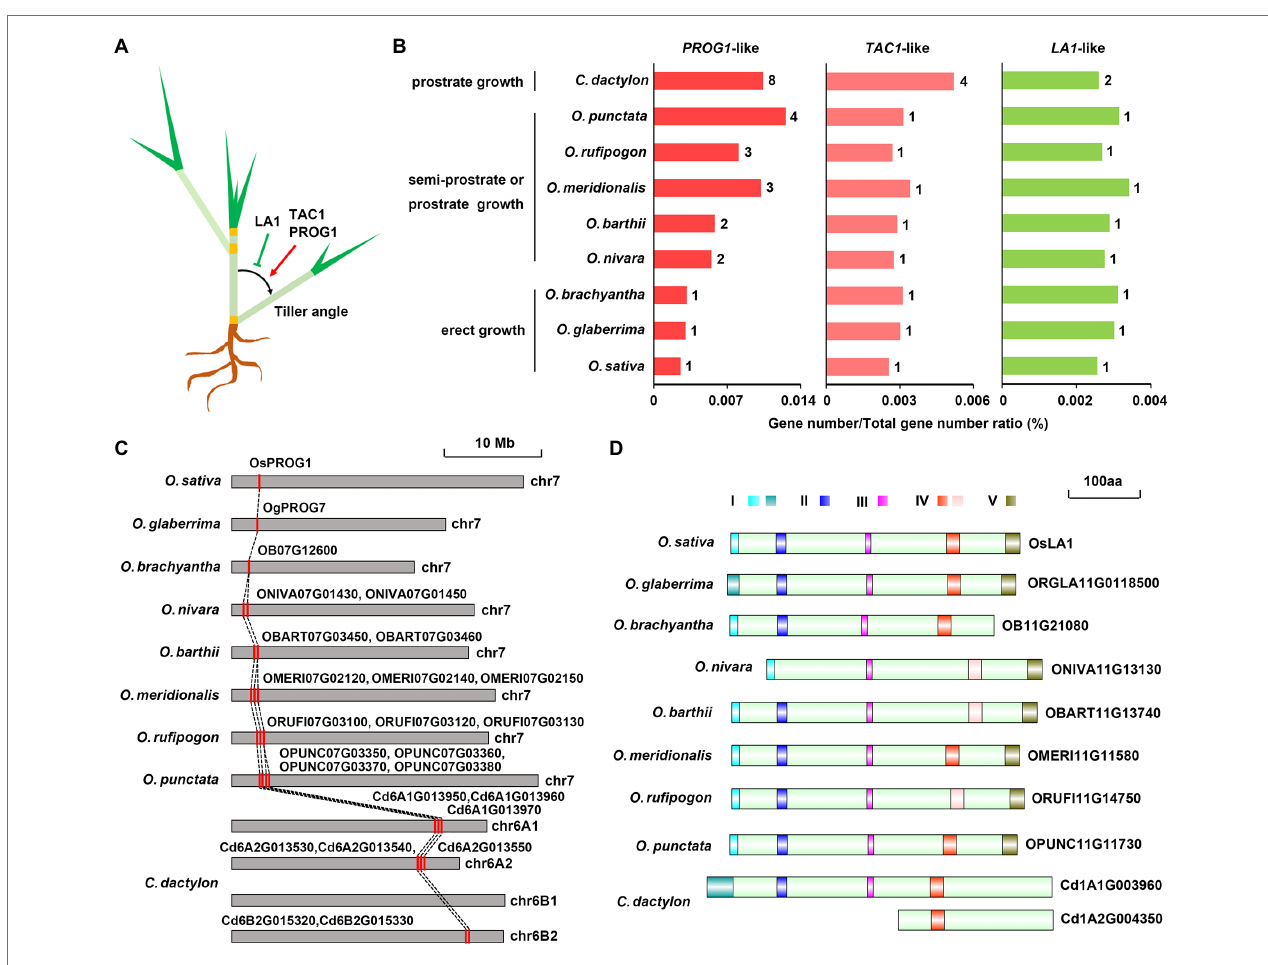
FIGURE 5 | Evolution of tiller angle-regulating genes in C. dactylon. (A) Diagram depicting the positive/negative regulatory roles of PROG1 , LAZY1 , and TAC1 genes in tiller angle control of grasses. (B) Comparison of the gene number of PROG1 -, LAZY1 -, and TAC1 -like genes in C. dactylon and eight species of Oryza genus with different growth habits. (C) Syntenic relationship of PROG1 -like genes in C. dactylon and eight species of Oryza genus with different growth habits. (D) Diagram showing the deficiency of key functional motifs in two LAZY1-like proteins of C. dactylon compared with those of eight species of Oryza